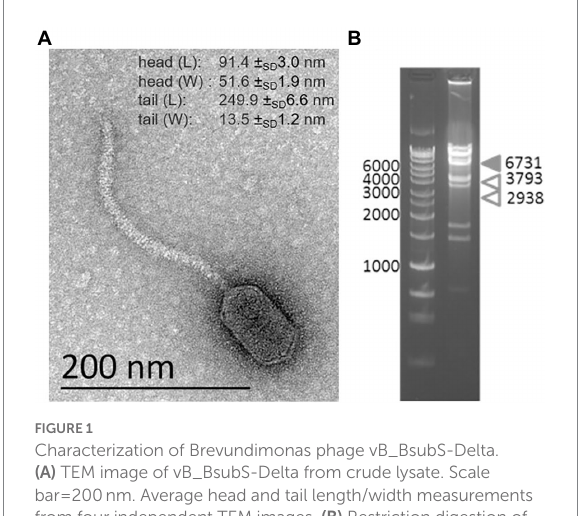
FIGURE 1 Characterization of Brevundimonas phage vB_BsubS-Delta. (A) TEM image of vB_BsubS-Delta from crude lysate. Scale bar = 200 nm. Average head and tail length/width measurements from four independent TEM images. (B) Restriction digestion of vB_BsubS-Delta genomic DNA with AflII and PciI to determine if the genome is linear or circular. Expected band sizes are indicated by